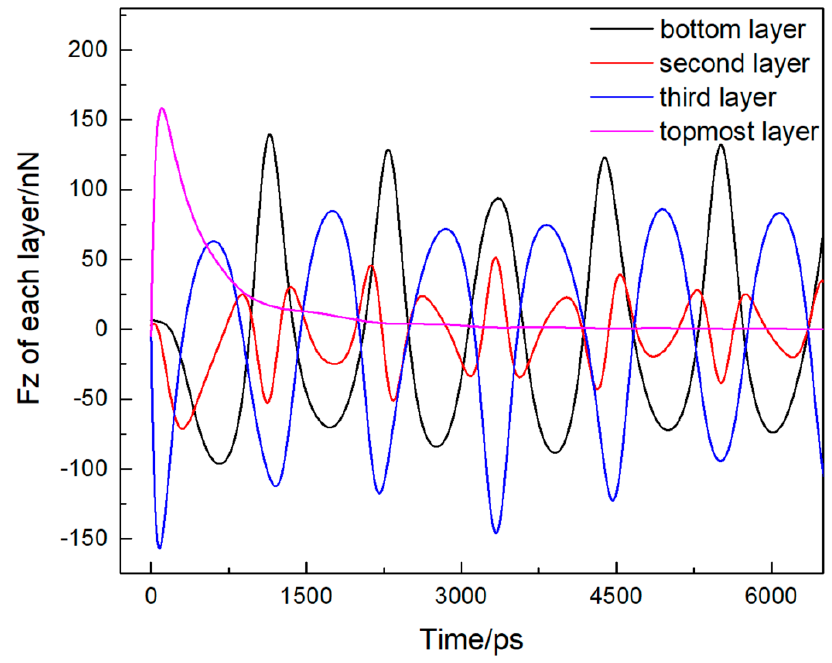
Figure 10. Fz to exfoliate each layer varying with time in four-layer graphene system, when the vertical upward velocity was 10.23 Å/ps.